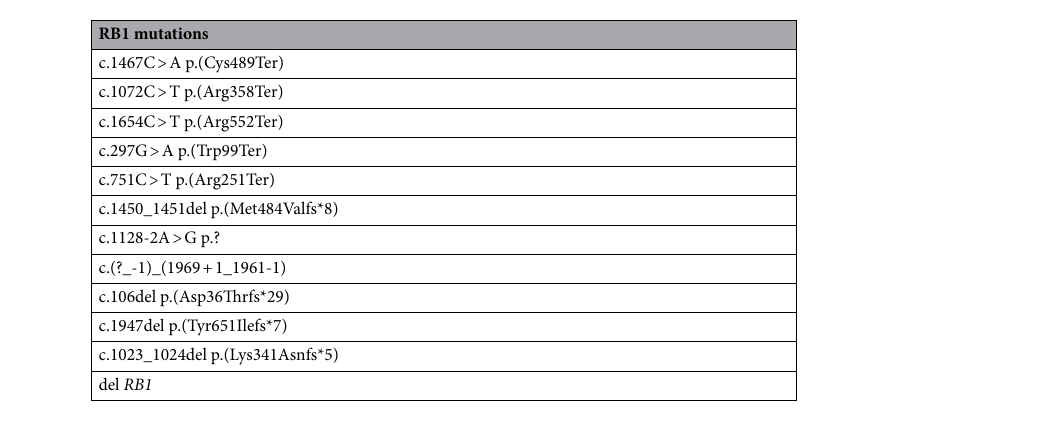
Table 2. Mutations found in genetic